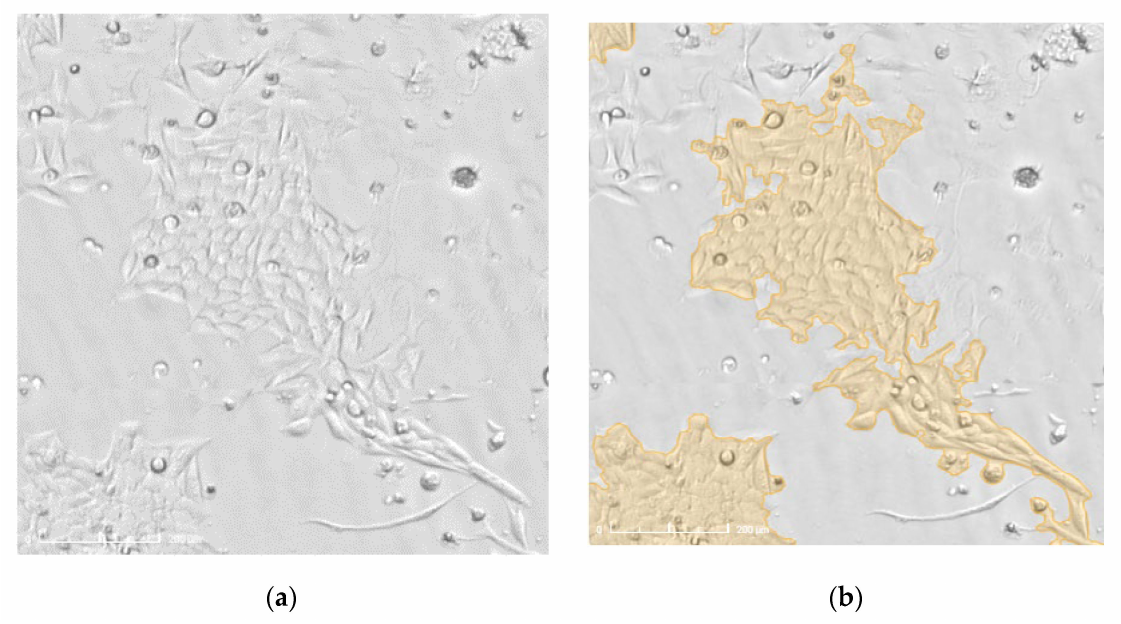
Figure A4. Images of T98G cells taken on the CytoSmart Omni. ( a ) T98G cells in a typical Omni image in brightfield viewing mode. ( b ) T98G cells under colony viewing mode. Colonies of sufficient size are displayed in the orange highlight and were included in colony